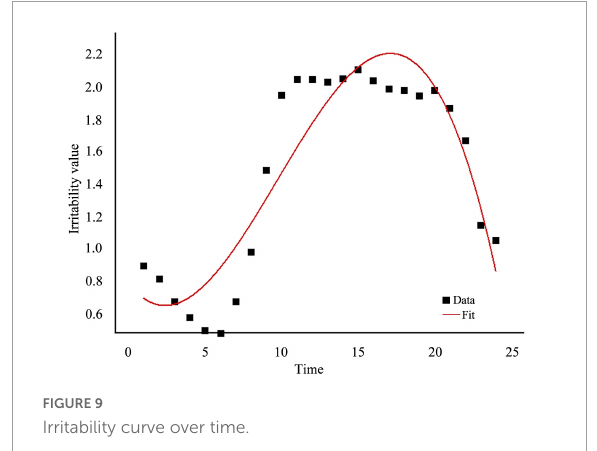
FIGURE9 Irritability curve over